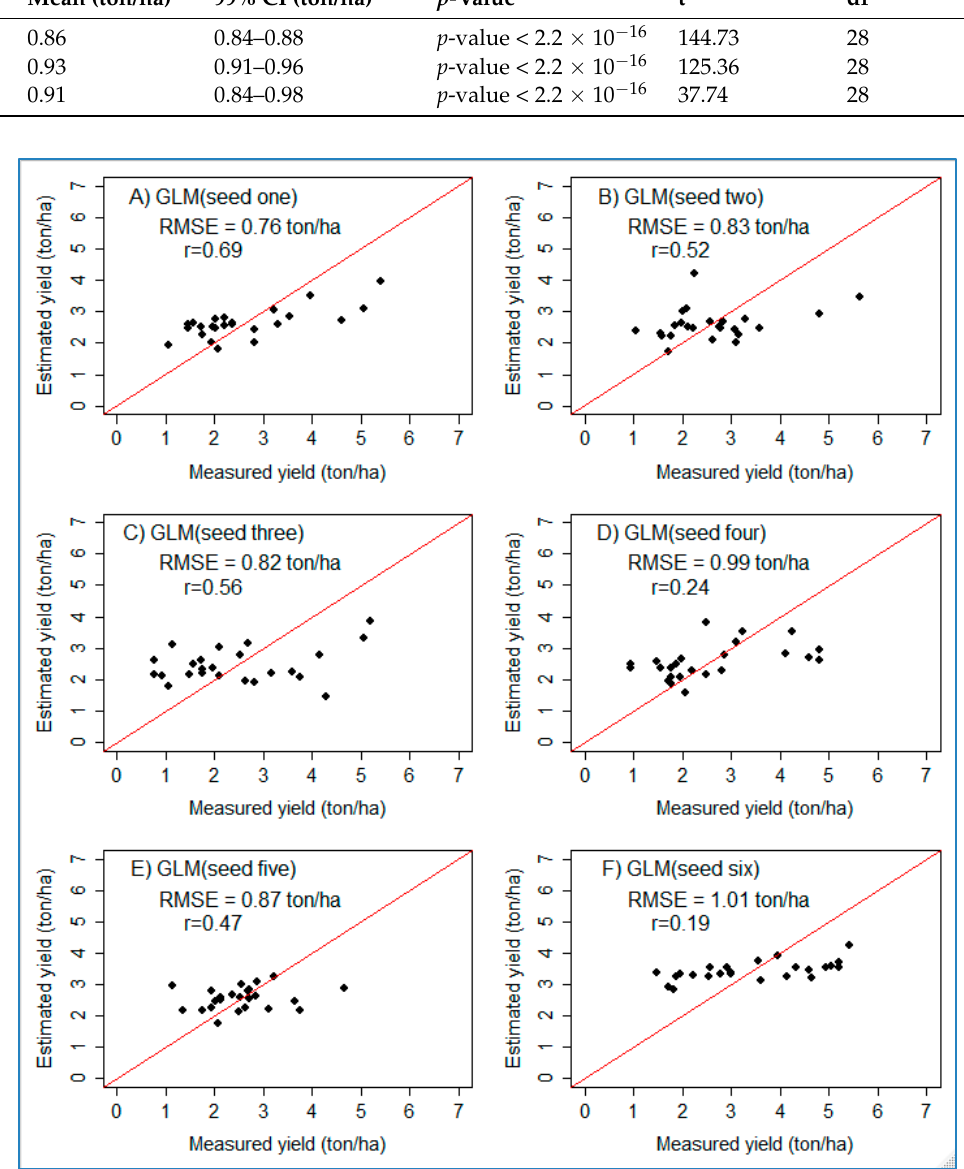
Figure 6. Scatter plots showing the performance of GLM on the test dataset for six randomly selected seeds. The red lines represent a 1:1 line between estimated and measured yields. Subfigures A–F refer to six plots prepared using six randomly generated numbers (seeds).